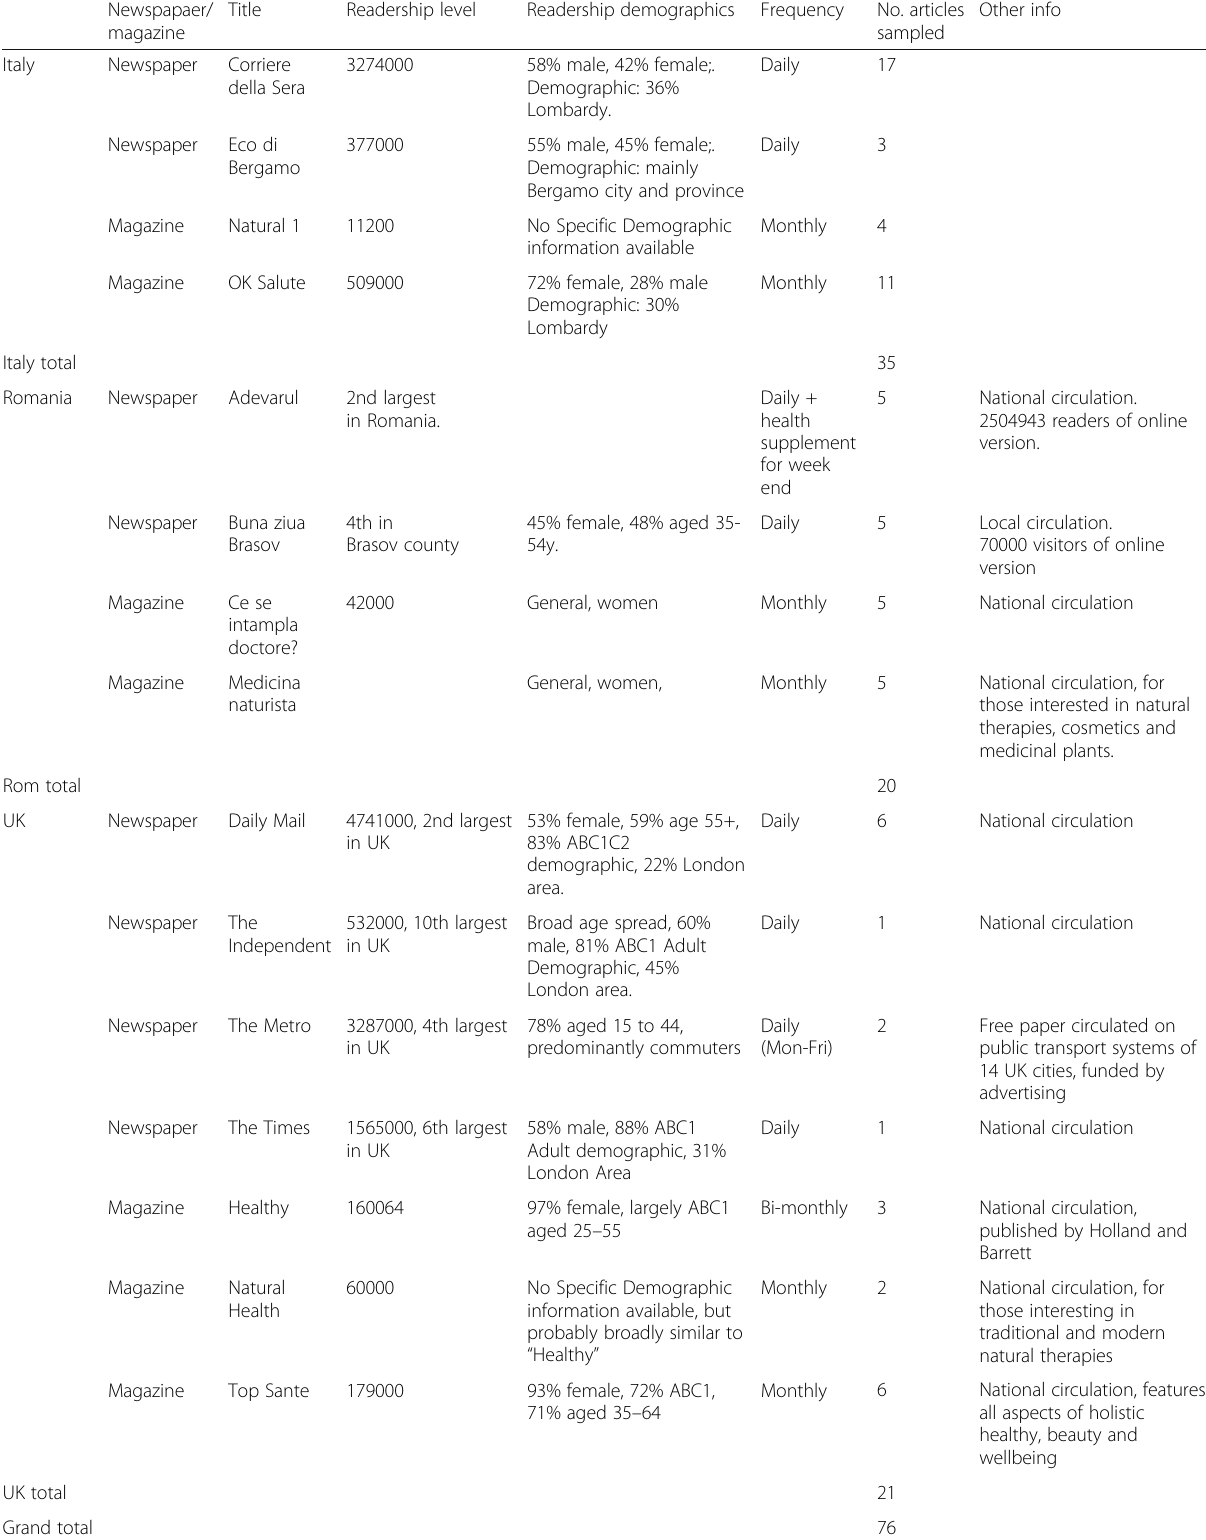
Table 1 Summary of publications surveyed in each